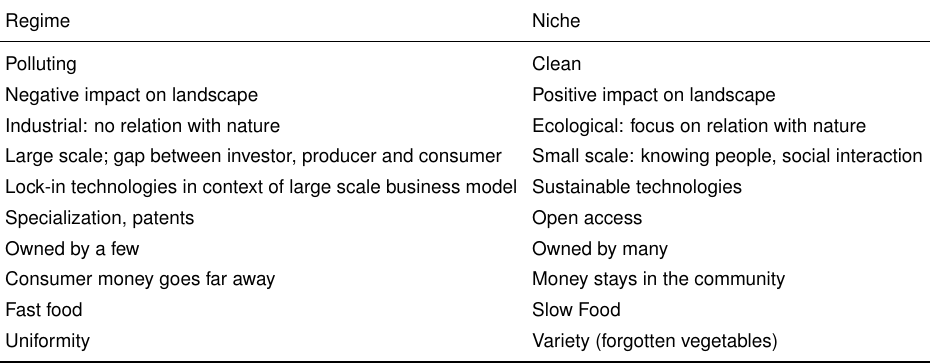
Table 1. Transition dialectics in framing the food system from a niche